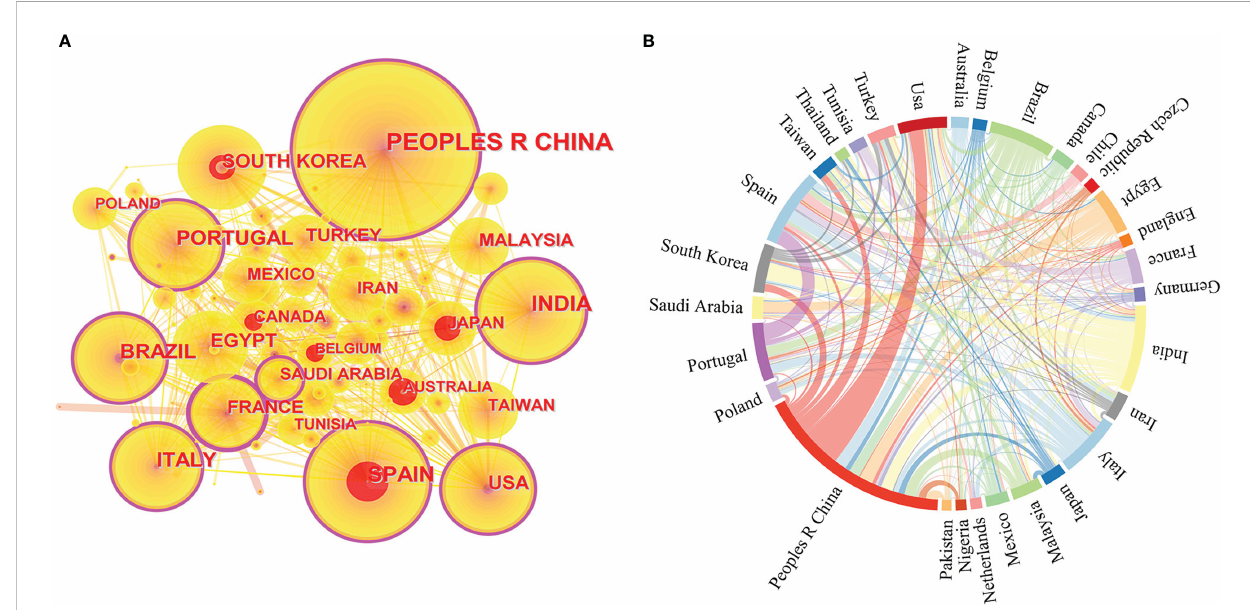
FIGURE 2 Based on the information of microalgae antioxidant research from 1996 to 2022, including (A) a network map of countries/regions cooperation created by CiteSpace; (B) a string diagram created by Gephi of the network of countries/regions